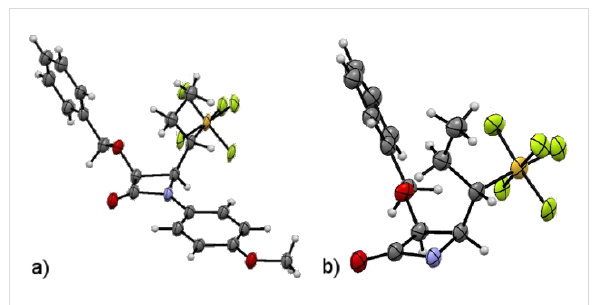
Figure 2: The stereochemistry of 7c, 1,2- lk,lk ( Si, Si-S ), as deter- mined by single crystal X-ray diffraction studies. Thermal ellipsoids are set at 50% probability. (a) Complete structure of 7c . (b) PMP protecting group hidden for